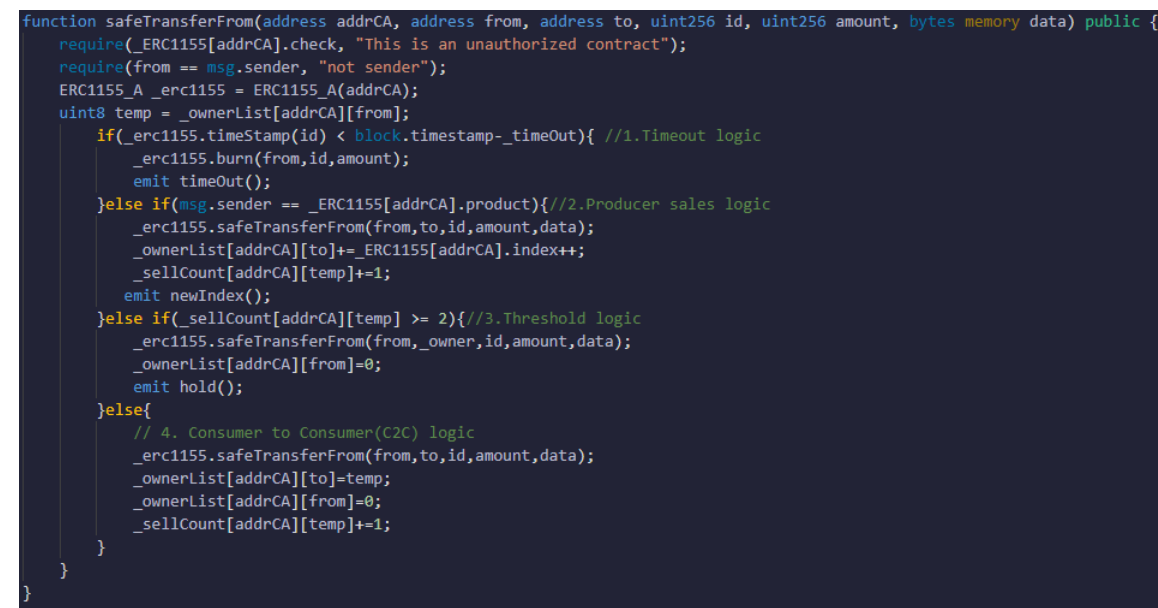
Figure 14. Token transfer code in Gateway contract.